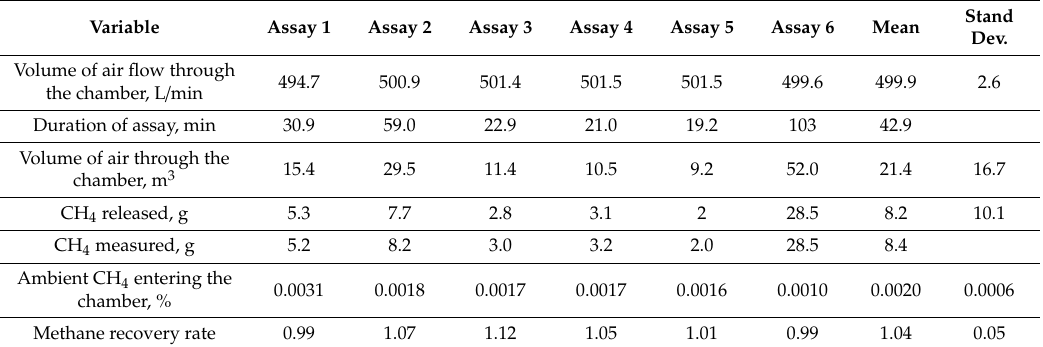
Table 1. Results of the full system recovery